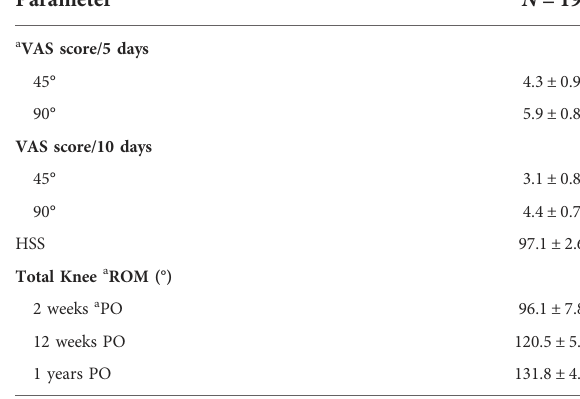
TABLE 1 Patient demographics and intraoperative data.